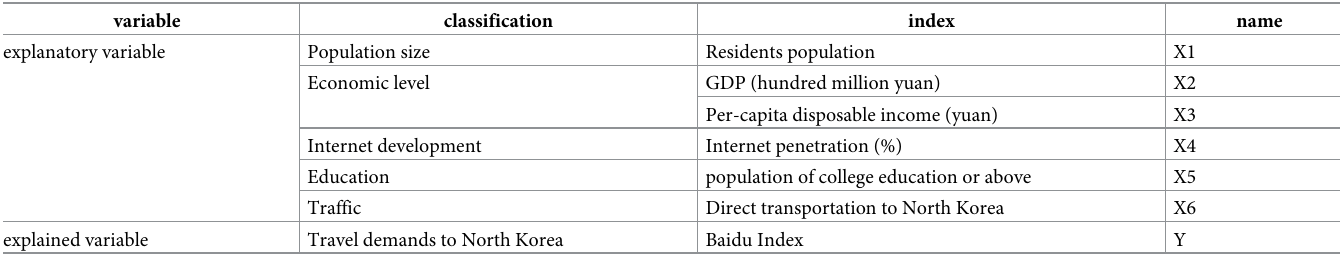
Table 3. Influencing factors of travel demands to North Korea.